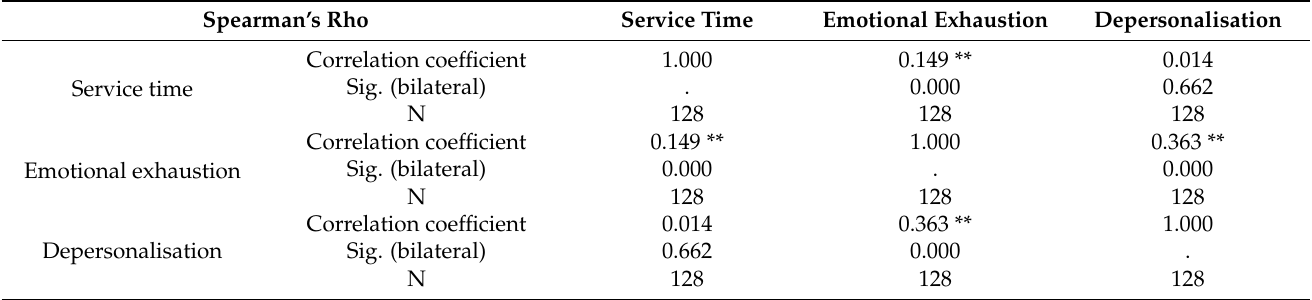
Table 5. Correlation of Spearman’s Rho for emotional exhaustion and depersonalization with